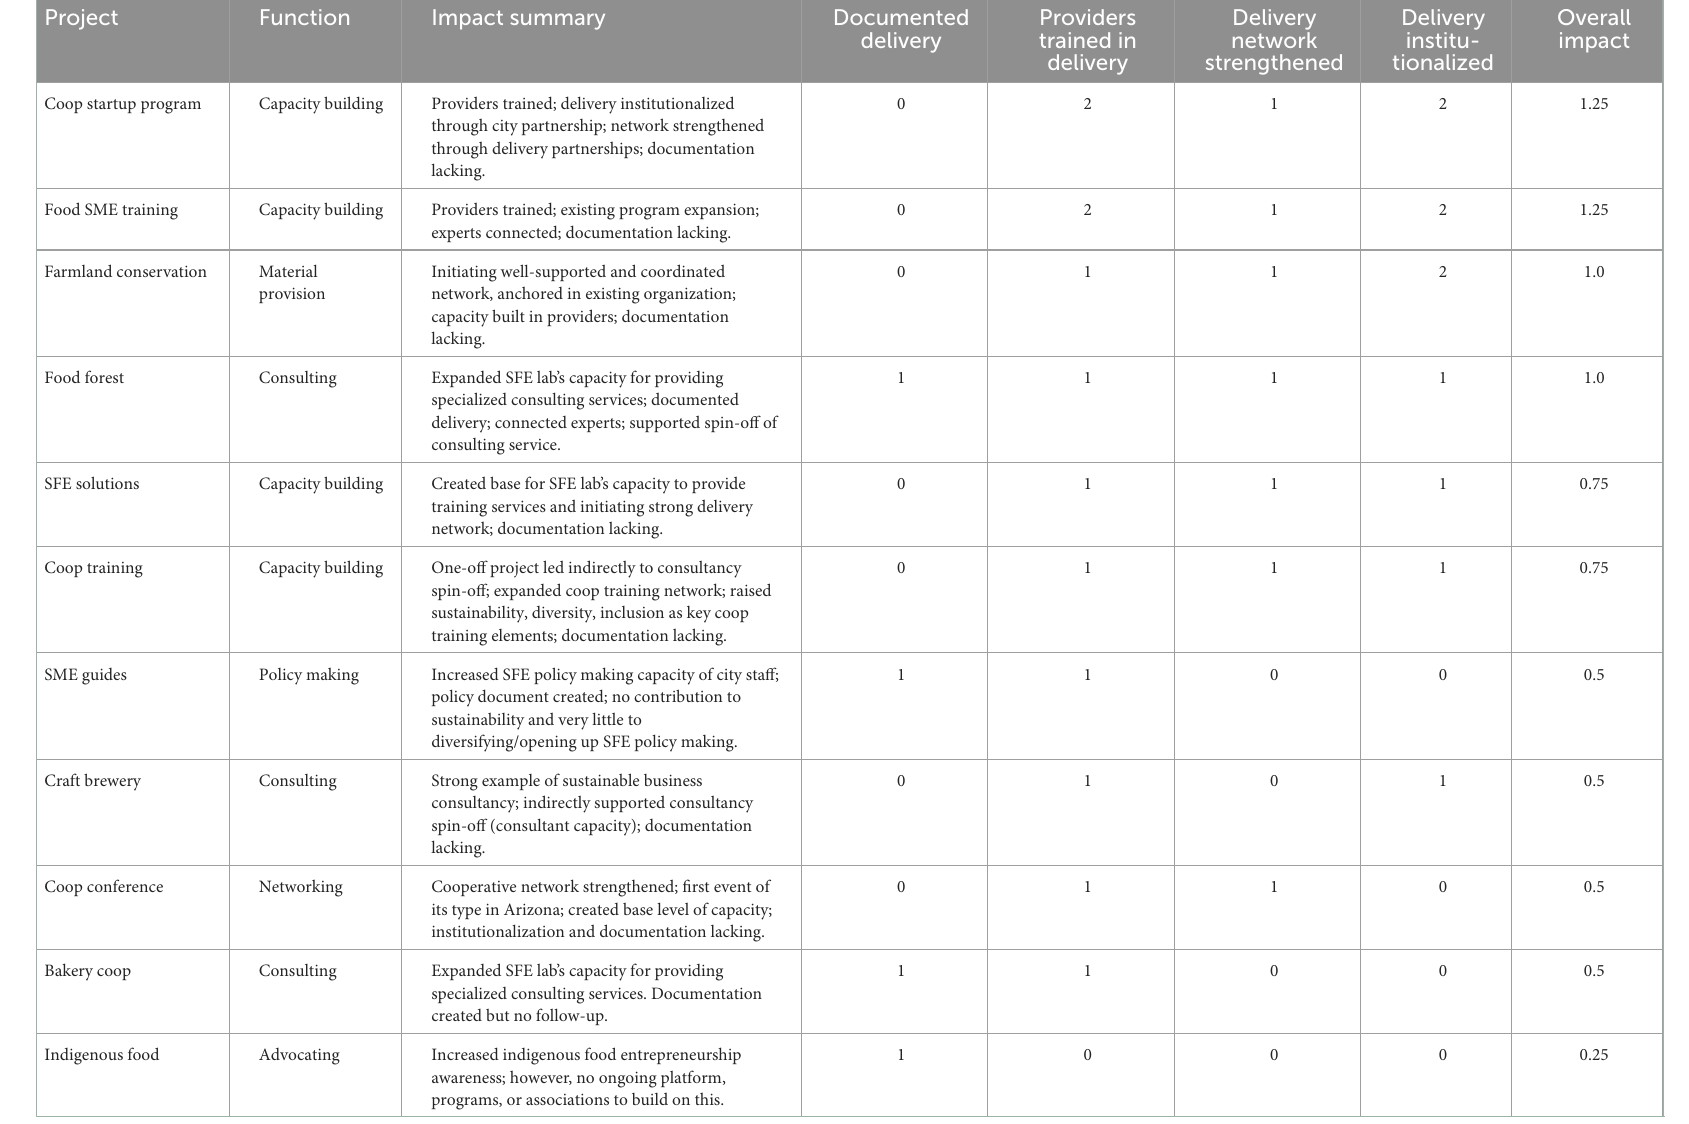
TABLE 6 Summary appraisal of each project’s impact on SEE function elements (0 = weak, 1 = medium, and 2 = strong), and overall impact rating